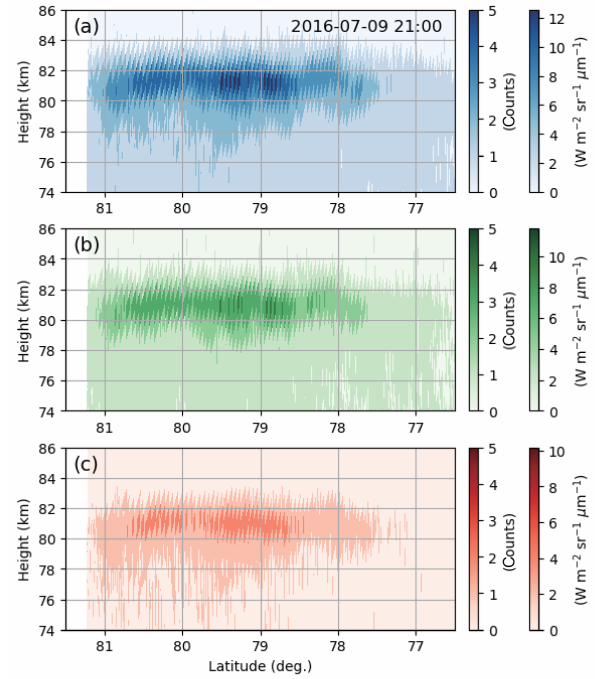
Figure 2. (a) Height–latitude distribution of emission intensity in the blue band at 21:00UT on 9 July 2016. (b) Same as (a) , but in the green band. (c) Same as (a) , but in the red